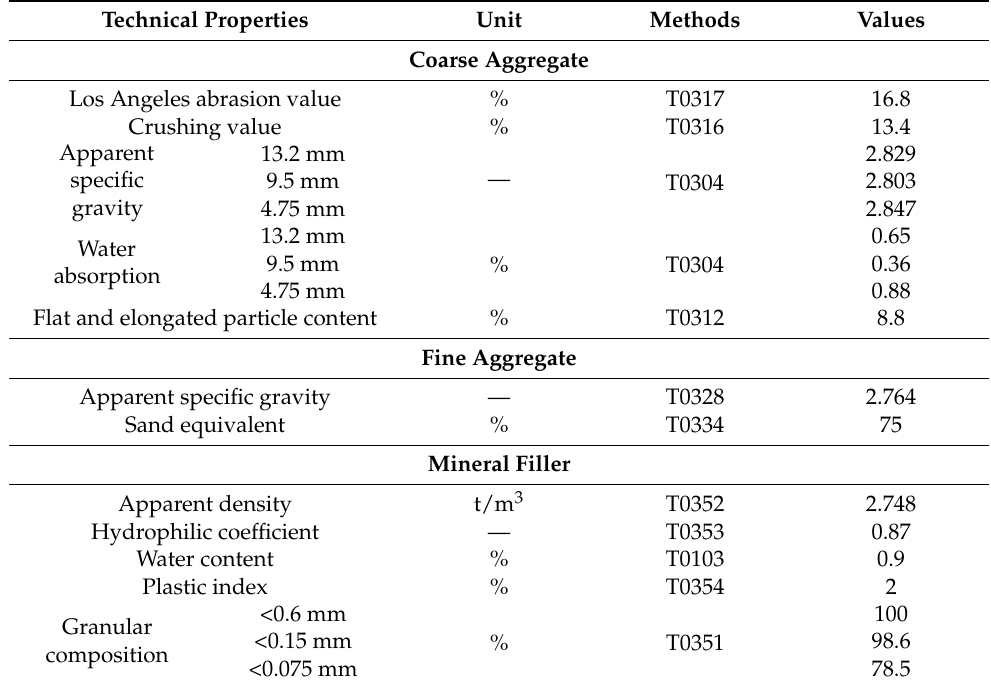
Table 3. Technical properties of aggregates and mineral